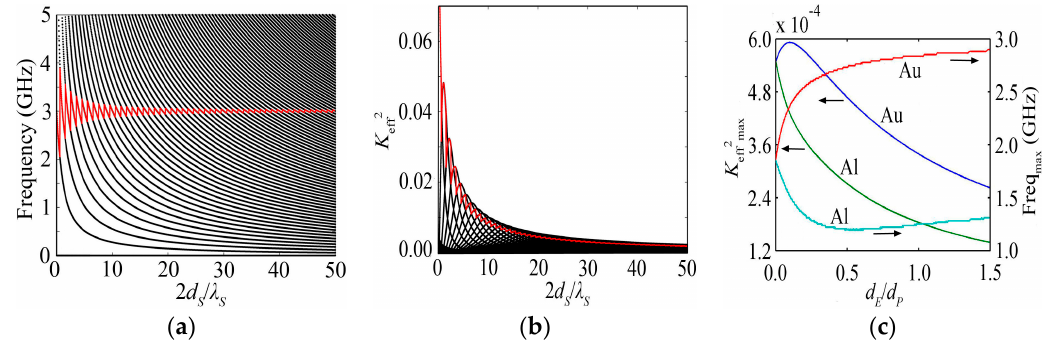
Figure 7. ( a ) The variation curve of the resonance frequency with the substrate thickness for the HBAR consisting of Au/ZnO/Au/Sapphire; ( b ) The variation curve of K eff2 with the substrate thickness for the HBAR consisting of Au/ZnO/Au/Sapphire; ( c ) The variation curve of K eff2max with d E / d P for the HBAR consisting of Au(Al)/ZnO/Au(Al)/Sapphire with the substrate thickness 2 d S / λ S of 200, where the blue and red lines represent K eff2max and Freq max of Au, respectively, and the green and light blue lines represent K eff2max and Freq max of Al, respectively.